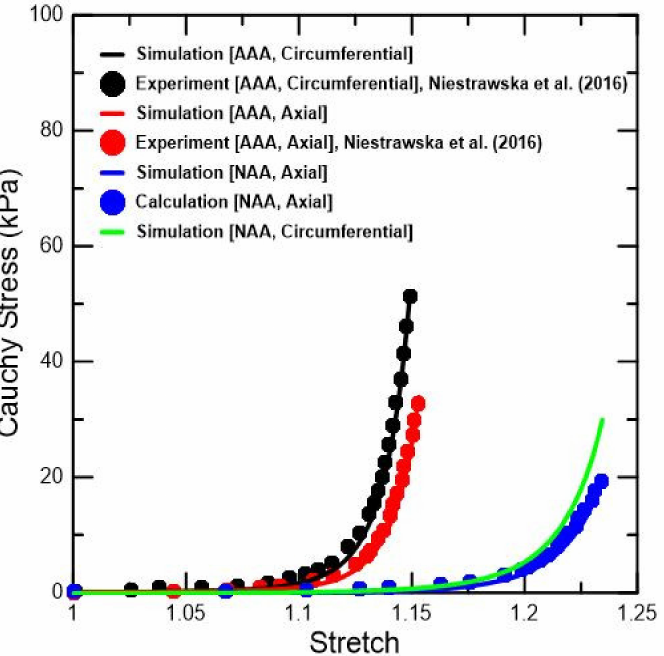
Stress–stretch curve of human abdominal aorta tissue from biaxial tensile test and